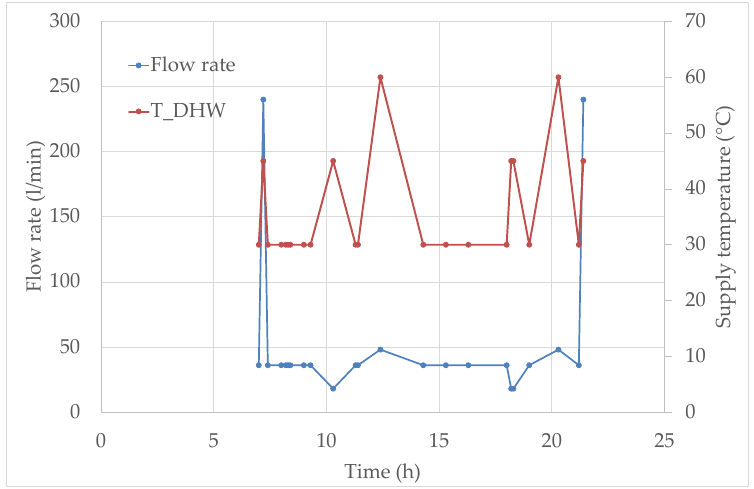
Figure 4. DHW daily tap profile.